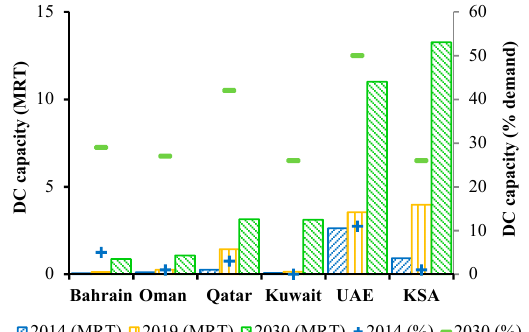
Figure 8. Installed (2014) and projected (2019, 2030) DC capacity potential in GCC countries, based on [5,17]. Percentage DC capacity is relative to total cooling requirement.